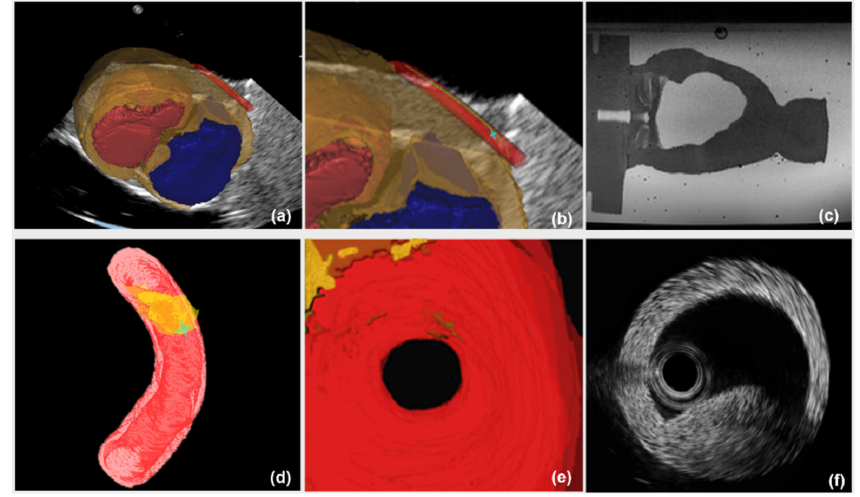
Figure 10. Image guidance interface and information. ( a ) a global navigation map from 2D US ‐ 3D MR registration; ( b ) enlarged view of a global map at the region of aorta, green curve is the preoperative planning path, asterisk denotes the position of interventional catheter; ( c ) collected MR image; ( d ) local navigation information with morphological characteristics of aorta. Dark yellow volume is lesion; ( e ) virtual visual image from endovascular view; ( f ) collected IVUS image.